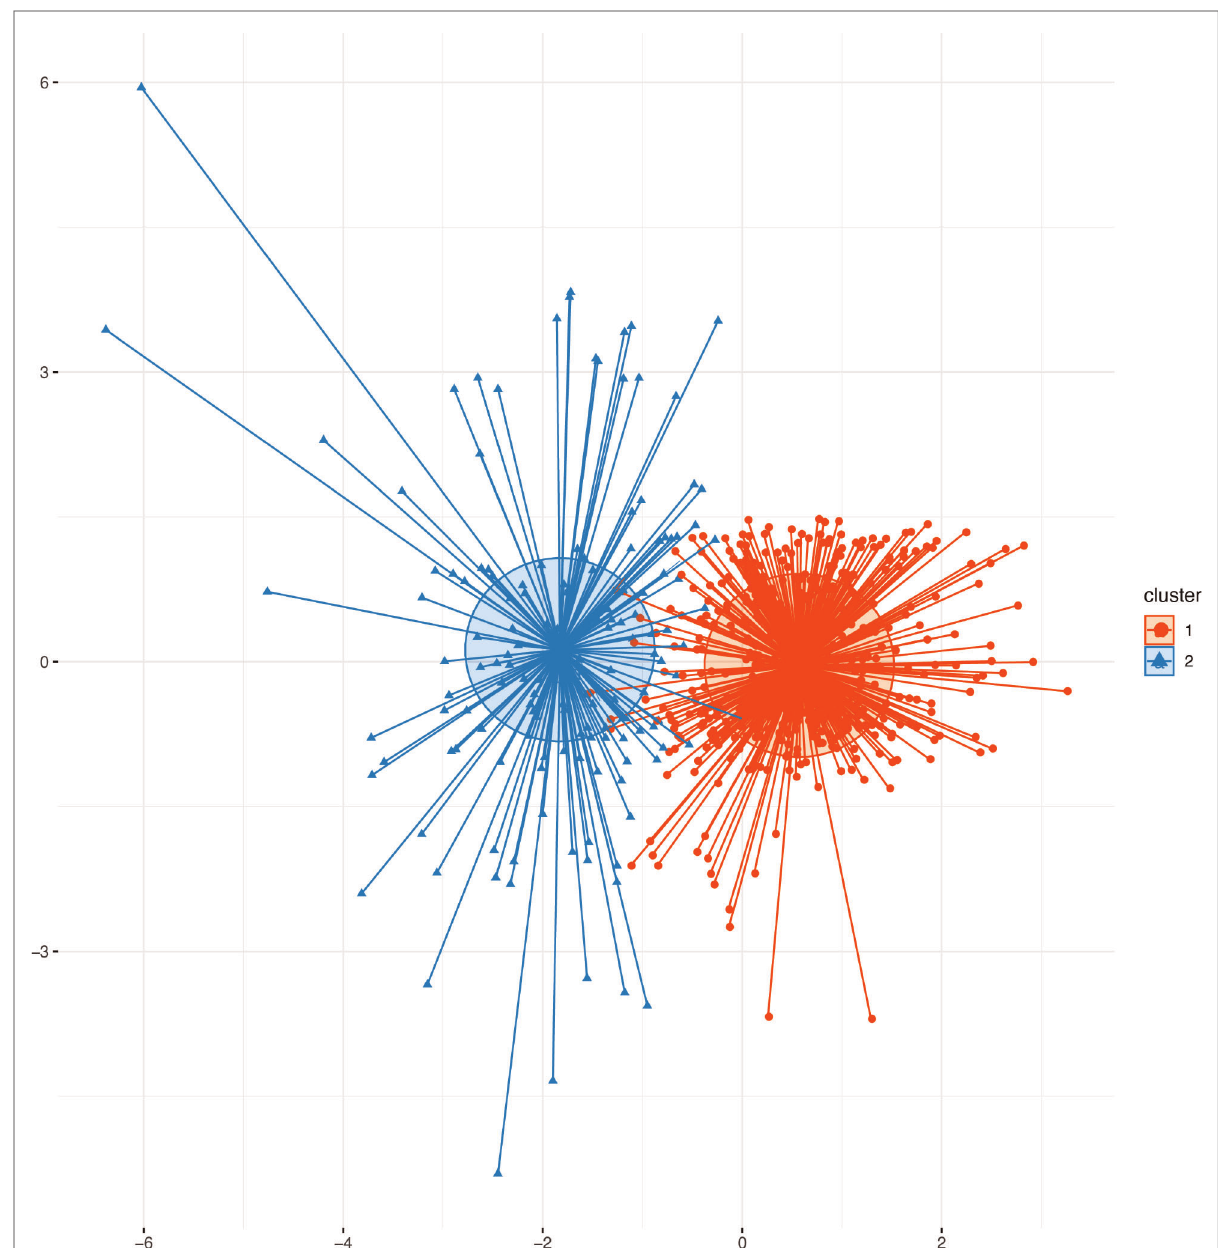
FIGURE 2 Scatter plots of patients ’ clinical data. Scatter points on the graph represent each patient, and the K-means clustering algorithm divides patients into two clusters. The orange scatter represents cluster 1, and the blue scatter represents cluster